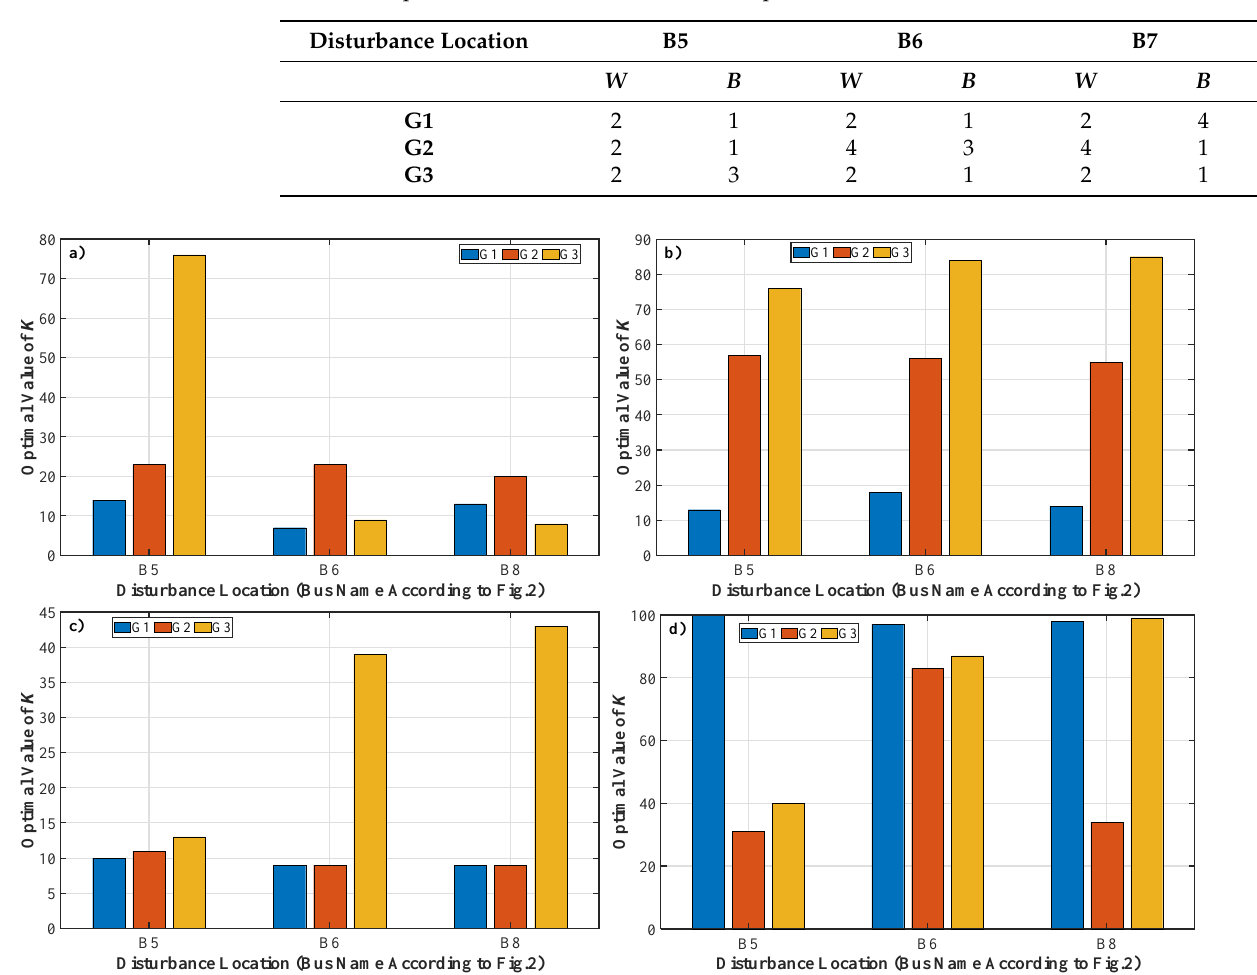
Figure 9. Impact of disturbance location on the optimal length of the analysis window. ( a ) Method #1, ( b ) Method #2, ( c ) Method #3, and ( d ) Method